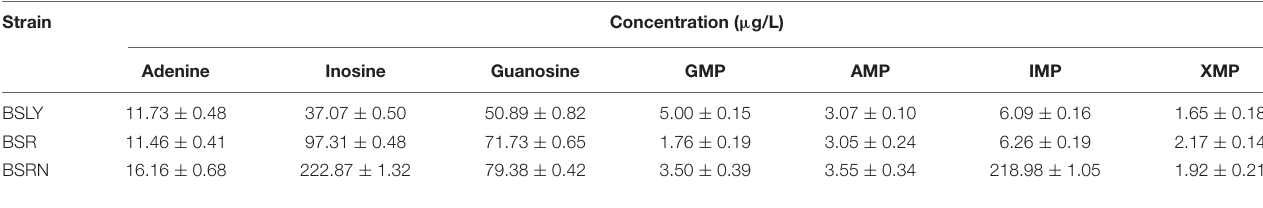
TABLE 1 | Concentration of purine compounds in the cultures of B. subtilis strains developed in this study.